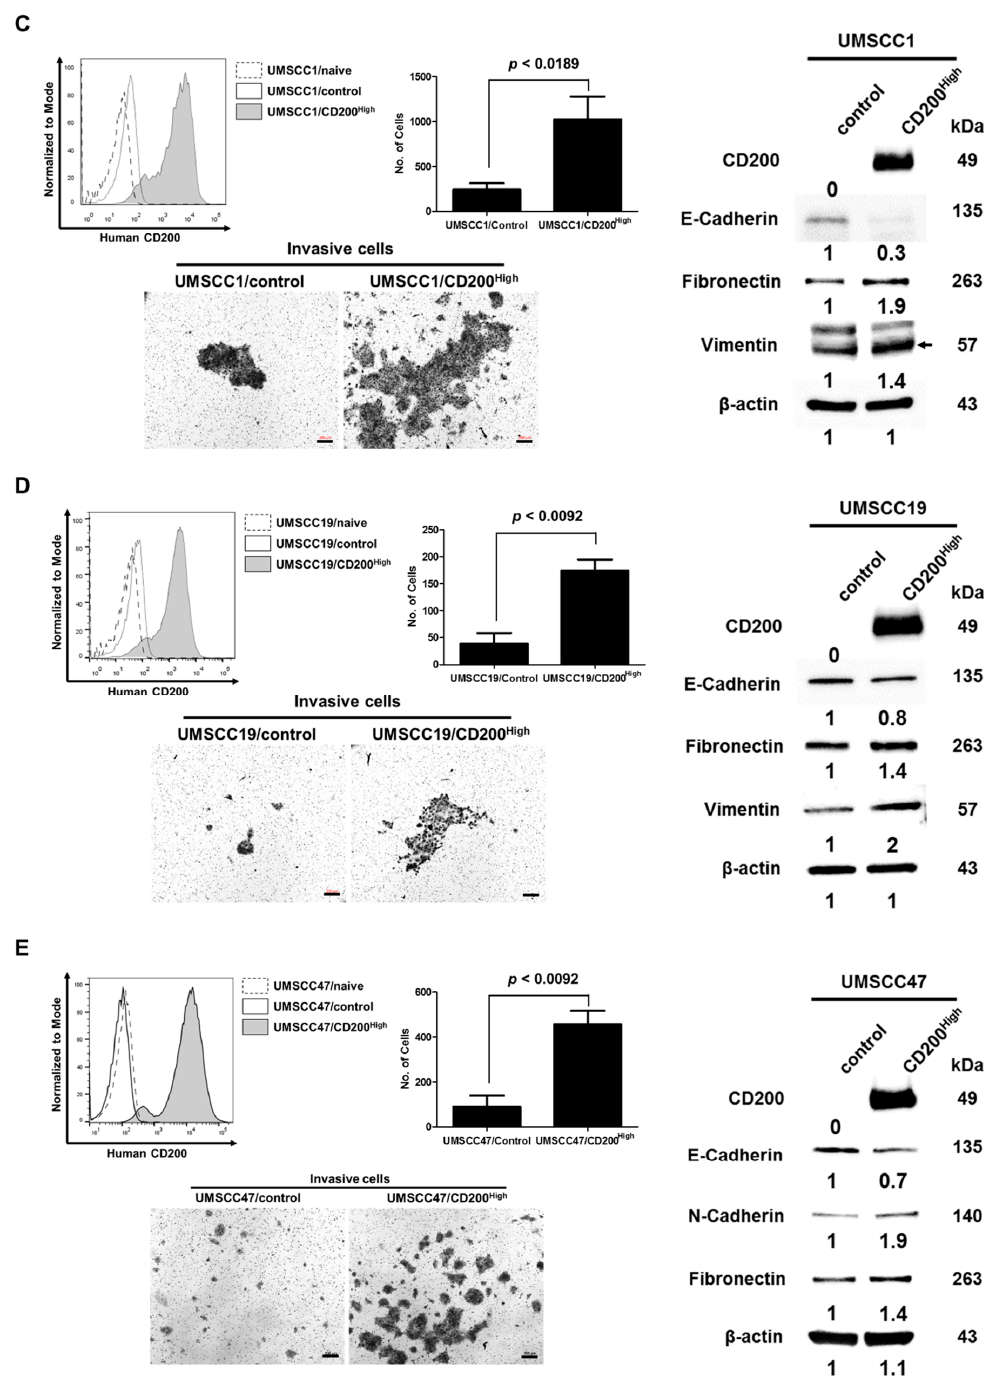
Figure 1. CD200 was upregulated in head and neck squamous cell carcinoma (HNSCC) patients and induced EMT. ( A ) CD200 mRNA expression in HNSCC patient samples in the TCGA dataset was analyzed by normalizing RNA-seq expression estimations by expectation maximization (RSEM). ( B – E ) UMSCC cell lines were transduced using a lentiviral vector carrying human CD200 and were sorted into UMSCC/CD200 High and UMSCC/control cells (upper left). The UMSCC/control cell was used as the control. Cells (1 × 10 5 )/well of each cell line was placed on Matrigel-coated Transwells and incubated for 48 h. Cells migrating to the underside of the filter through the Transwell were stained with crystal violet (200 µ m scale bar, lower panel) and counted under a microscope (upper right). Each error bar in the graph represents the average of three independent experiments (mean ± SEM). Protein (30 µ g) was used for western